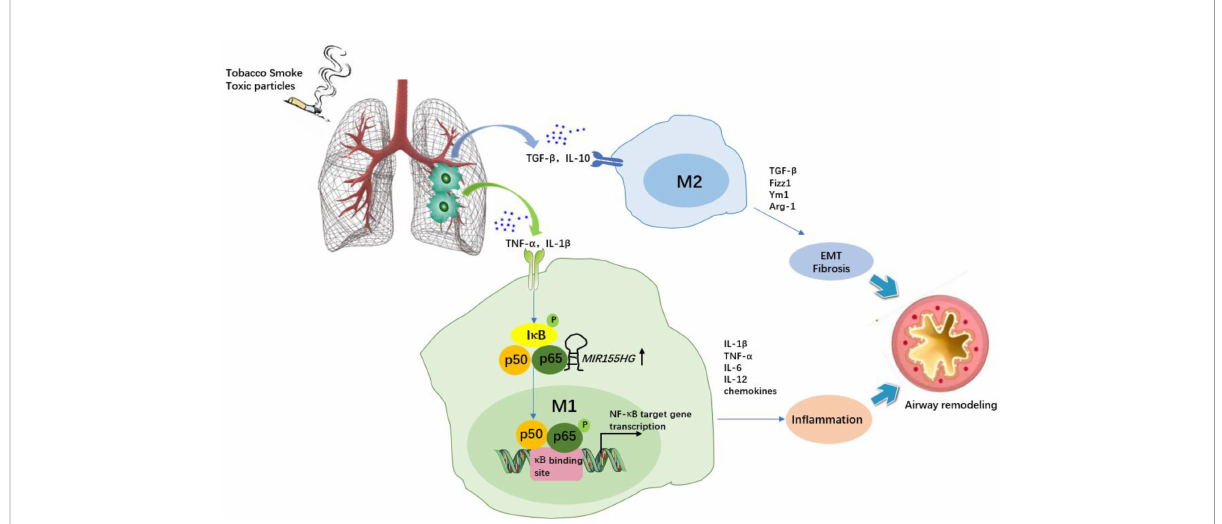
FIGURE 3 The role of macrophages and MIR155HG in chronic obstructive pulmonary disease (COPD). Tobacco smoke or toxic particles cause airway in fl ammation and airway remodelling. Macrophage polarization plays a key role. M1 macrophages secrete in fl ammatory cytokines and chemokines, promoting neutrophil recruitment and augmenting airway in fl ammation. MIR155HG indirectly regulate NF- k B signaling activity by interacting with the p65-p50 complex, resulting in M1 macrophages activation accompanied by enhanced proin fl ammatory cytokine release (TNF- a , IL-1 b and IL-12). M2 macrophage-induced TGF- b , Fizz1 and Ym1 are involved in epithelial mesenchymal transformation (EMT) and extracellular matrix dynamics, and arginine accelerates collagen synthesis, which leads to fi